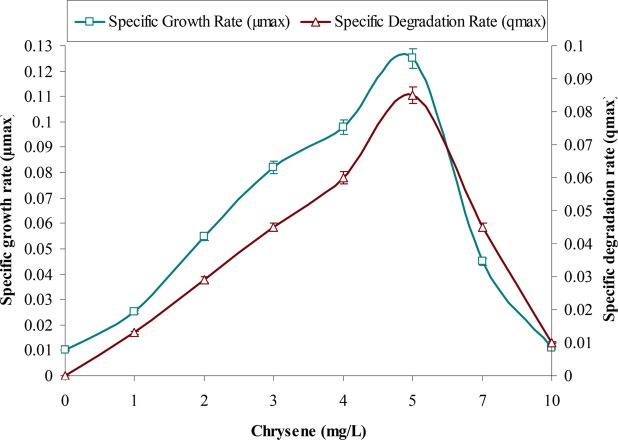
Effect of chrysene concentrations on growth rate (μmax) of the consortium ASDC and (its) degradation rate (qmax), at 37°C and pH 7, 150 rpm in BHM.